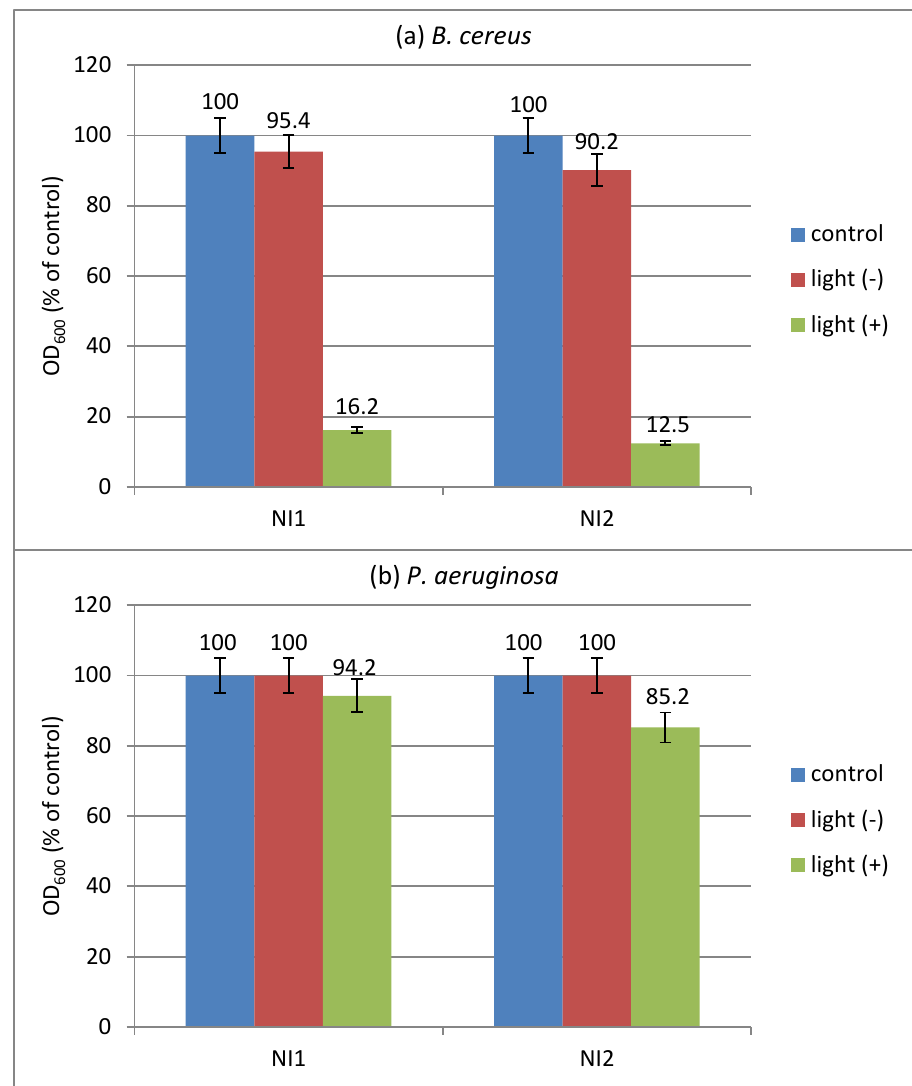
Figure 6. Effect of light irradiation on the antimicrobial action of untreated cotton fabrics (control), and cotton fabrics treated with NI1 and NI2 (red and green color) towards ( a ) B. cereus and ( b ) P. aeruginosa.